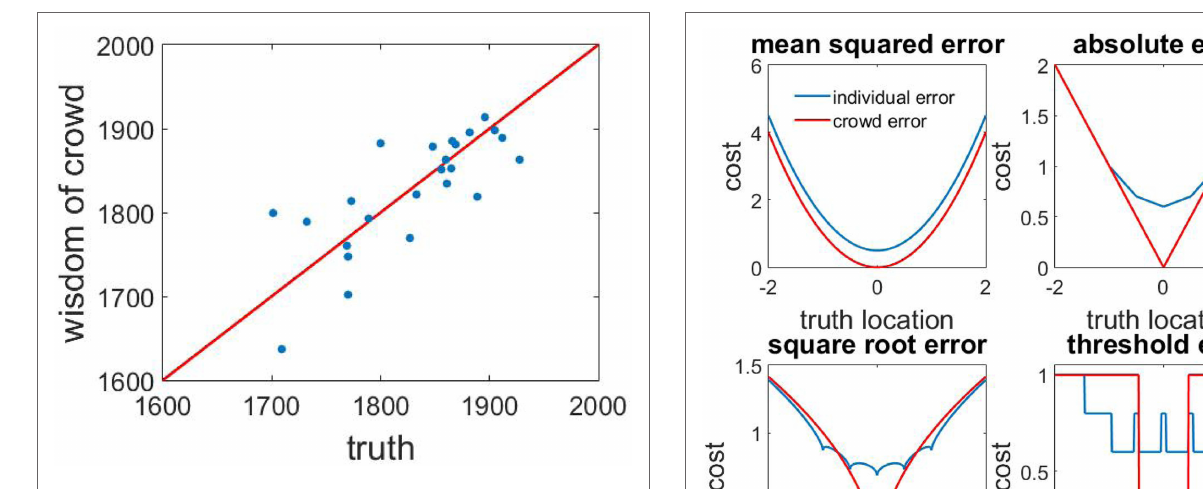
FIGURE 4 | Wisdom of the crowd for historical dates. Mean of 50 independent opinions versus true values for 24 questions concerning historical dates. The red line marks the ideal performance curve; real performance frequently strongly deviates from that line. Data from Yaniv and Milyavsky (2007).